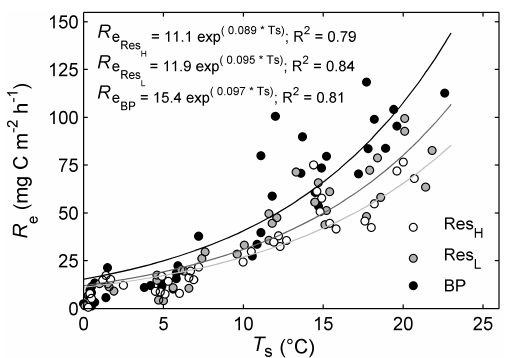
Figure 5. Response of nitrous oxide (N 2 O) fluxes (µgNm − 2 h − 1